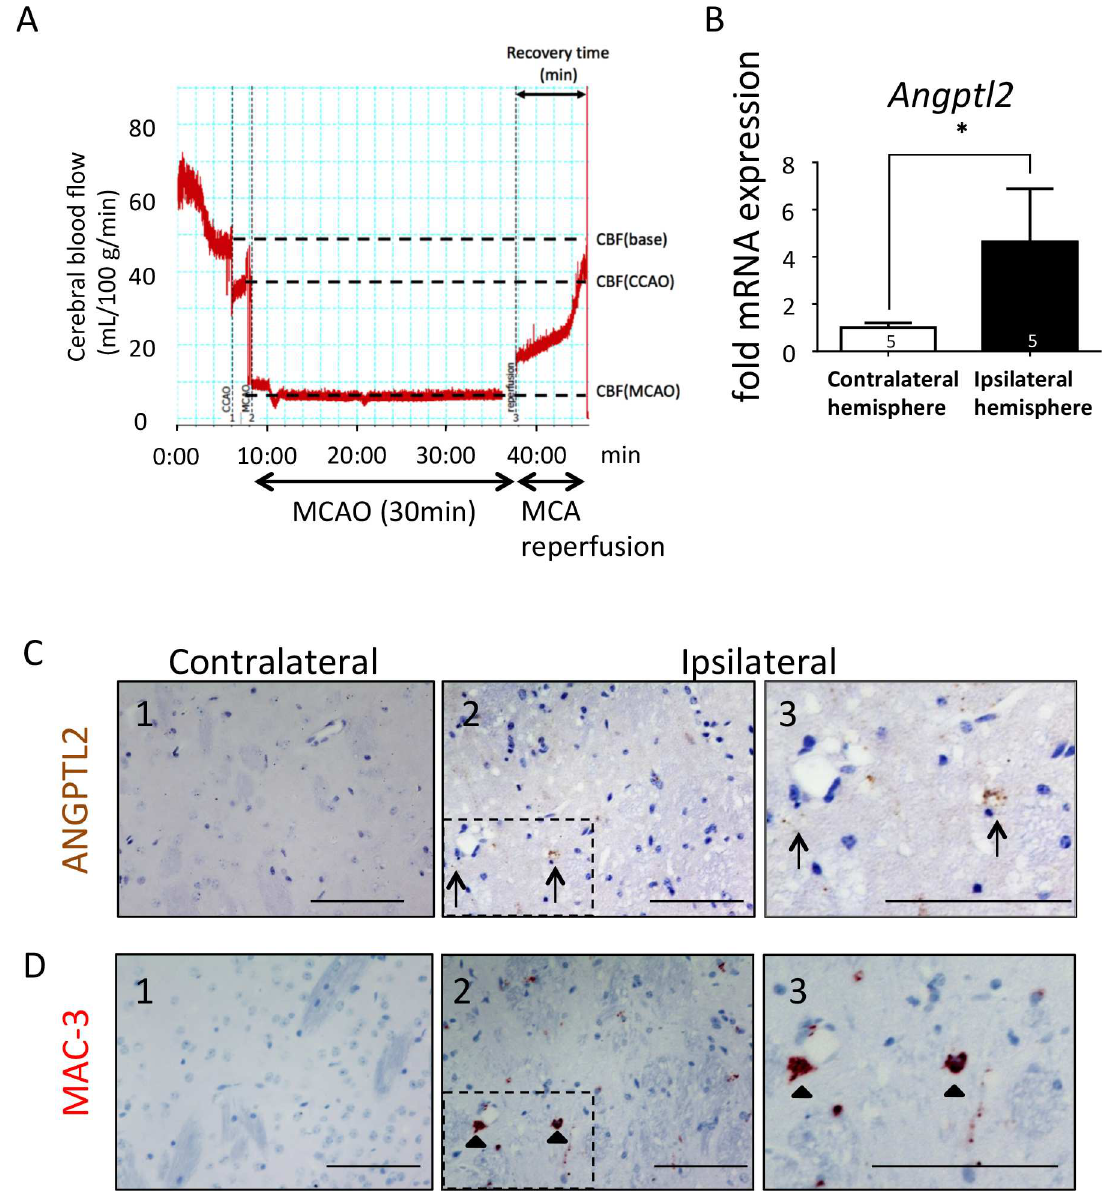
Fig 1. The number of infiltrated ANGPTL2-positive macrophages increasesin ischemic brain. ( A ) Representative image of cerebralblood flow measured by laser Dopplerflowmeter in the vicinity of the middlecerebralartery duringtransient middlecerebralartery occlusion(MCAO) surgery. MCA, middlecerebralartery. A laser Dopplerflowmetry probe was used to trace cerebral blood flow (CBF). After ligationof the right common carotid artery (CCAO), we observed a 40% drop in CBF. MCA occlusionpromoteda further decreaseto less than 80–90%of baselineCBF. After 30 min MCAO, the suture was removedand the right common carotid artery was permanently ligated to prevent bleeding,resultingin a slow return of CBF to approximately 60% of baselinelevels. CBF tracing was comparable in WT and Angptl2 KO mice duringMCAO and subsequent reperfusion. ( B ) Angptl2 mRNA levels in the ischemic hemisphere 24 hours after transient MCAO (n = 5). Values indicate Angptl2 expressionrelative to Tbp mRNA. Results are expressedas means ± s.e.m. * P < 0.05.( C ) ANGPTL2 immunostaining in mouse brain. (Panel 1) Representative image showingANGPTL2 expressionin the contralateral cerebral hemisphere. (Panels 2, 3) Representative images showingANGPTL2 expressionin the ipsilateralhemisphere. Panel 3 is highermagnification image of the square in panel 2. Arrows indicateANGPTL2-positive cells. ( D ) MAC-3 immunostaining in mouse brain. (Panel 1) Representative image showingMAC-3 expressionin the serial section shown in panel 1 of ( C ). (Panels 2, 3) Representative images of MAC-3 in serial sections shown in panels 2 and 3 of ( C ). Panel 3 is a highermagnification image of the square shown in panel 2. ArrowheadsindicateMAC-3-positive cells. Scale bars: 100 μ